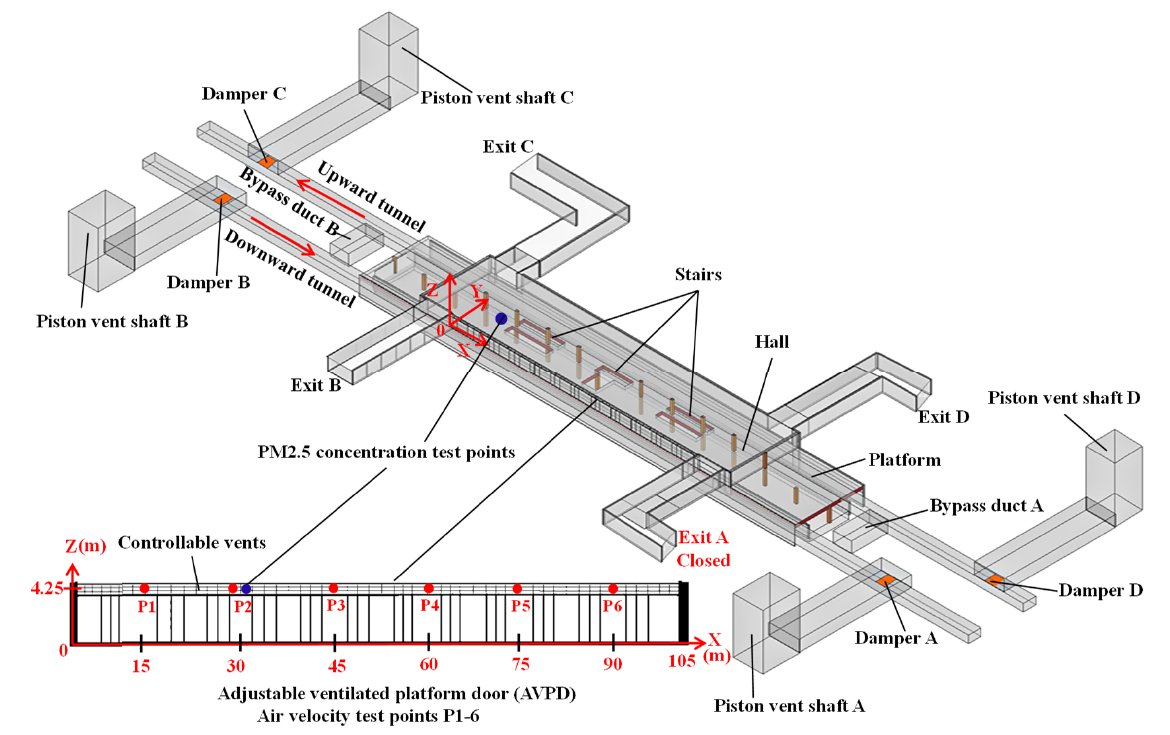
Figure 1. Schematic of the Zhangmatun subway station. Table 1. Detailed geometric parameters of the Zhangmatun subway station.